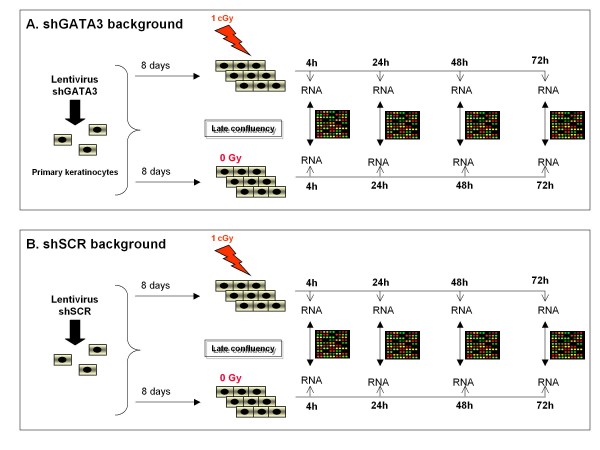
Experimental strategy of the transcriptome analysis.